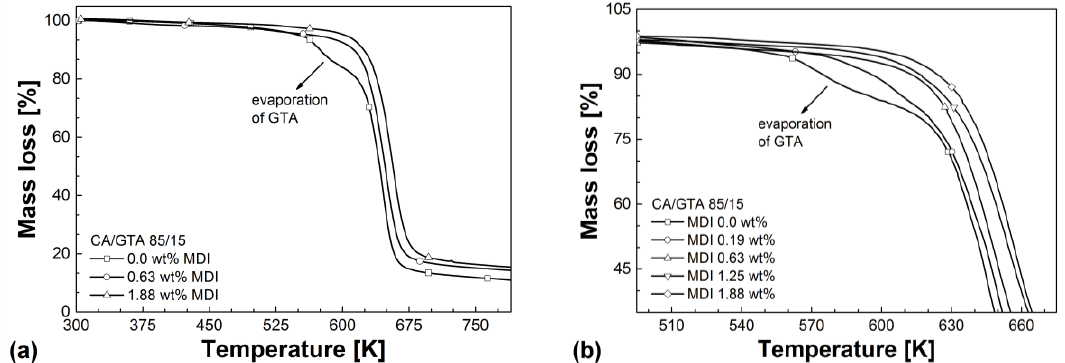
Figure 13. ( a ) Mass loss as a function of temperature for CA/GTA (85/15) in comparison to CA/GTA (85/15) with 0.63 wt% MDI and 1.88 wt%. ( b ) Mass loss as a function of temperature for CA/GTA/MDI in dependence of MDI content.